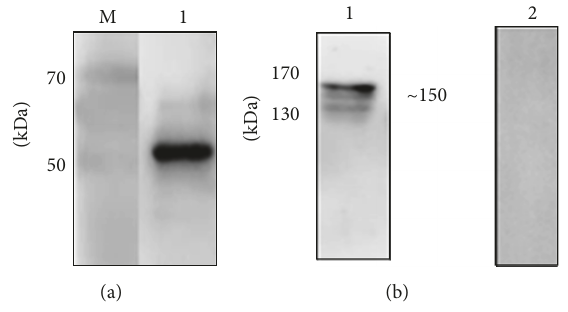
Figure 4: Western blot of recombinant protein BoRON2-C . (a) A specific band of 53 kDa was detected in reaction of recombinant Bo RON2 with anti B. orientalis water buffalo serumonline1 andline M the prestained protein marker. (b) Immunoblot for detection of Bo RON2 protein in parasite lysates. Line 1, a unique band of around 150 kDa was detected in parasite lysate probed with polyclonal Bo RON2 antibody; line 2: no band detected with preimmune serum in parasite